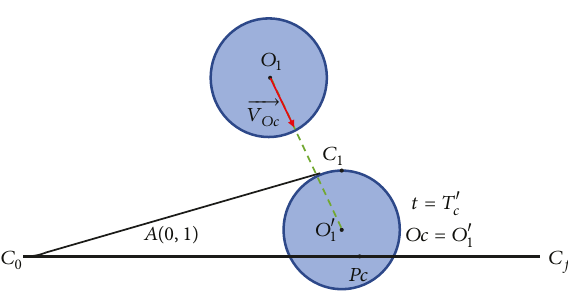
Figure 5: The implementation example of the HTE strategy in moving obstacle